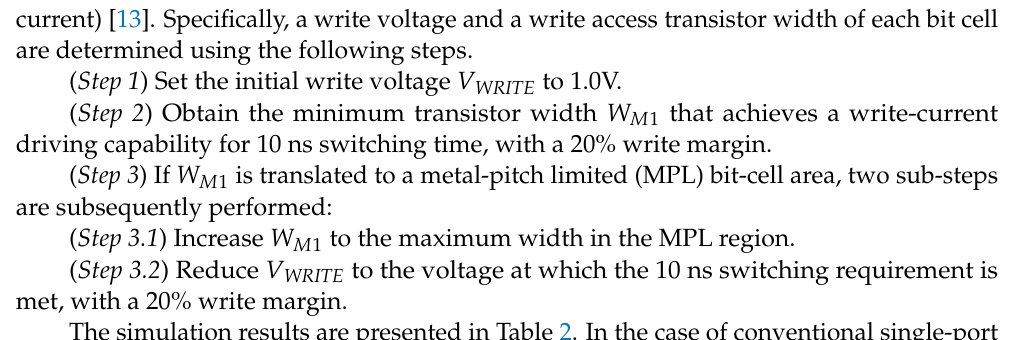
Conventional Conventional Single-Port STT-MRAM